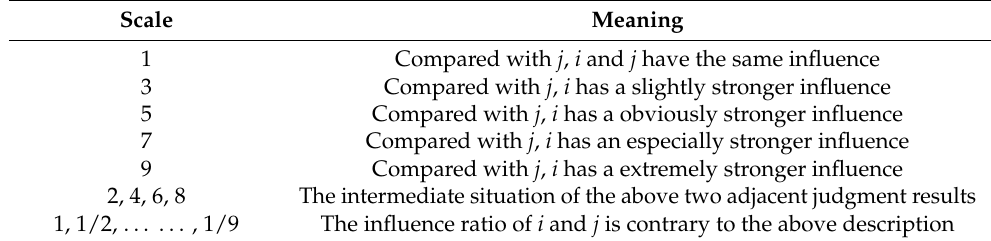
Table 3. Scale meaning of “nine scale”